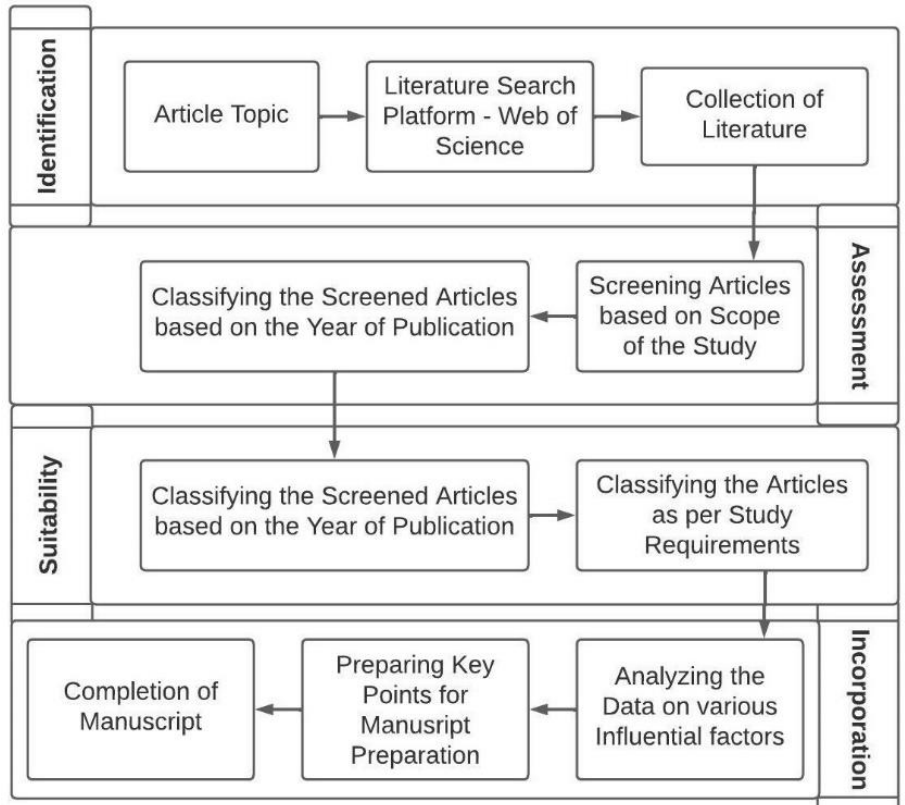
Figure 1. Methodology. Figure 1.